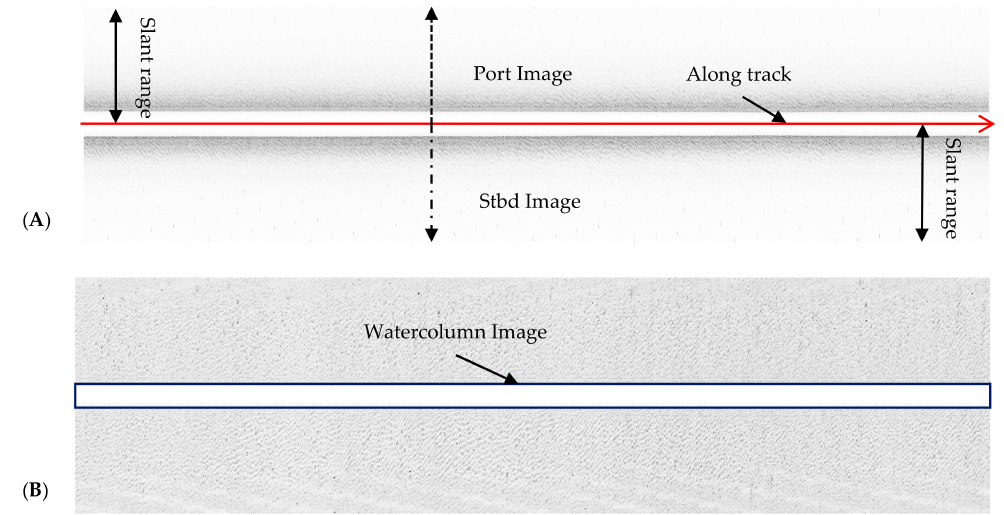
Figure 14. Single strips of ( A ) a raw SSS image and ( B ) a corrected image of ( A